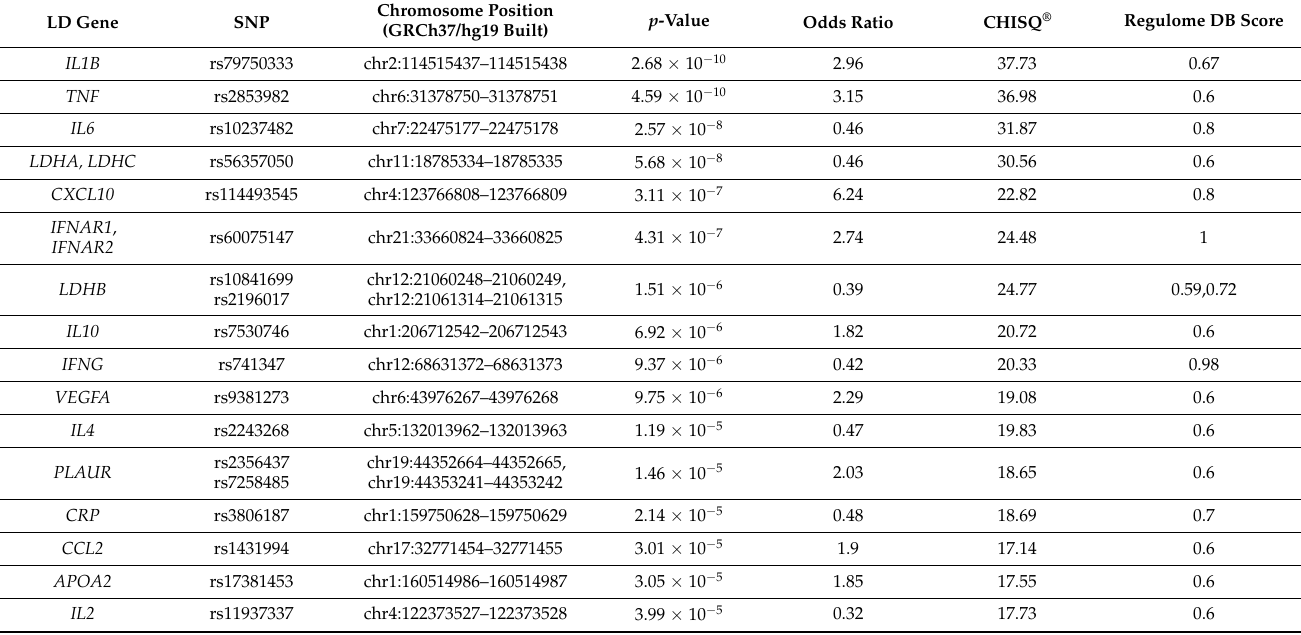
Table 4. Functional SNPs within genes associated with severe COVID-19 and significantly different MAF in Spanish/Italian populations when compared to other European